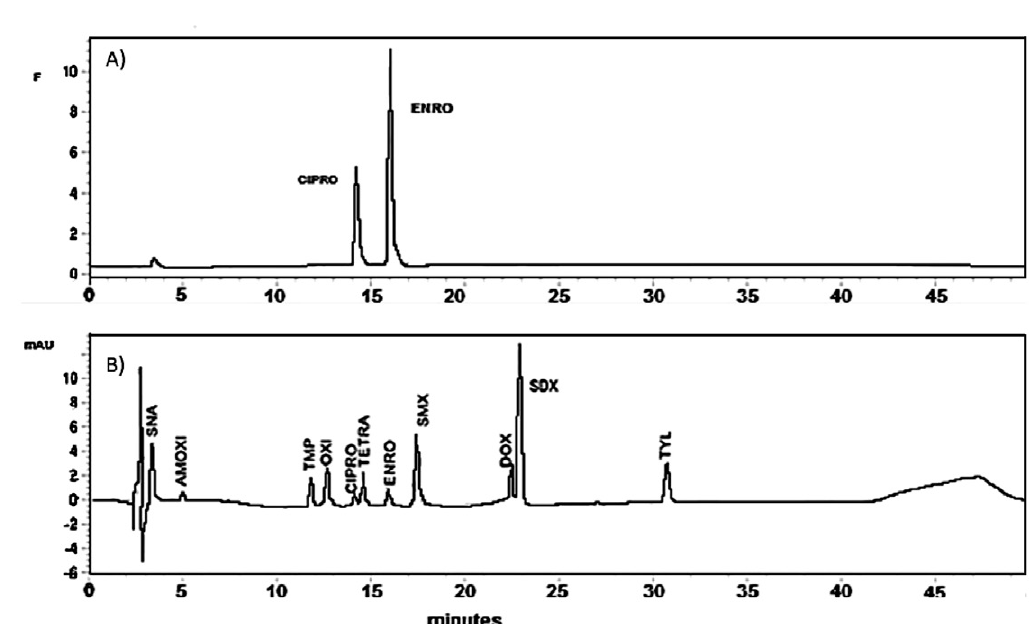
Figure 2. Chromatogram of the mixture of antibiotics. (A) fluorescence detection (λ ex 278nm and λ em 450 nm); (B) UV detection 280 nm. Elution order was amoxicillin (AMOXI), trimethoprim (TMP), oxitetracycline (OXI), ciprofloxacin (CIPRO), tetracycline (TETRA), enrofloxacin (ENRO), sulfamethoxazole (SMX), sulfadimethoxine (SDX), doxycycline (DOX) and tylosin (TYL). Separation conditions are described in